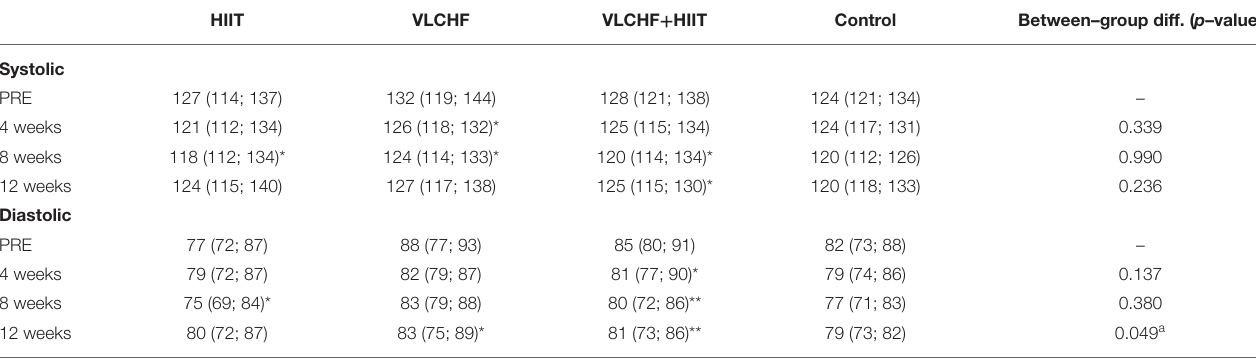
TABLE 3 | Blood pressure outcomes. HIIT VLCHF VLCHF + HIIT Control Between–group diff. ( p